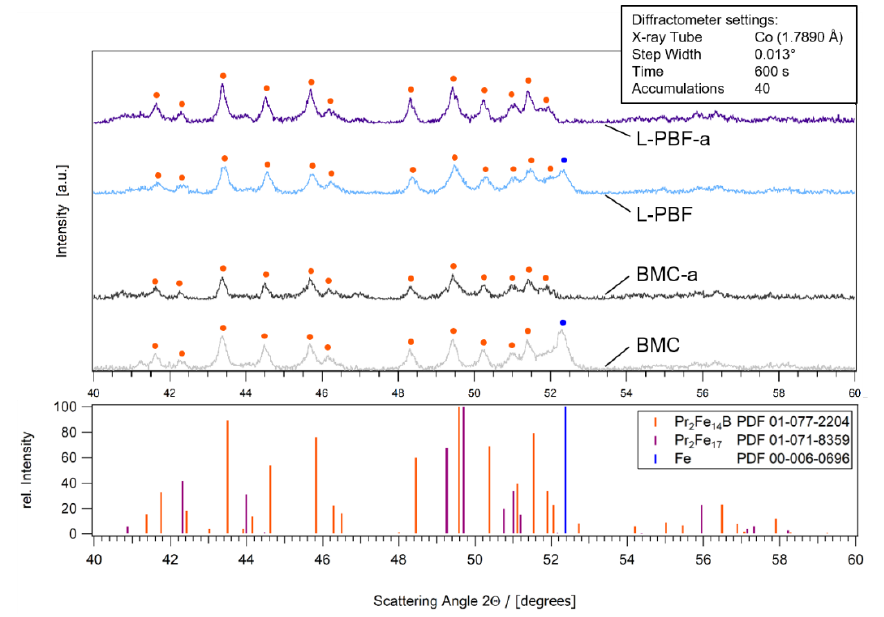
Figure 7. Diffractograms of 3D-printed Fe73.8-Pr20.5-Cu2.0-B3.7 in the as-built state ( L-PBF ) (light blue) and annealed state ( L-PBF-a ) (blue) and the reference BMC material in the as-cast state ( BMC ) (light gray) and annealed state ( BMC-a ) (gray) in comparison. As reference, the relative intensities of Fe 14 Pr 2 B, Fe 17 Pr 2 and Fe from literature are shown. The phases that have been identified in the X-ray diffraction (XRD) chart are marked in the diffractograms.